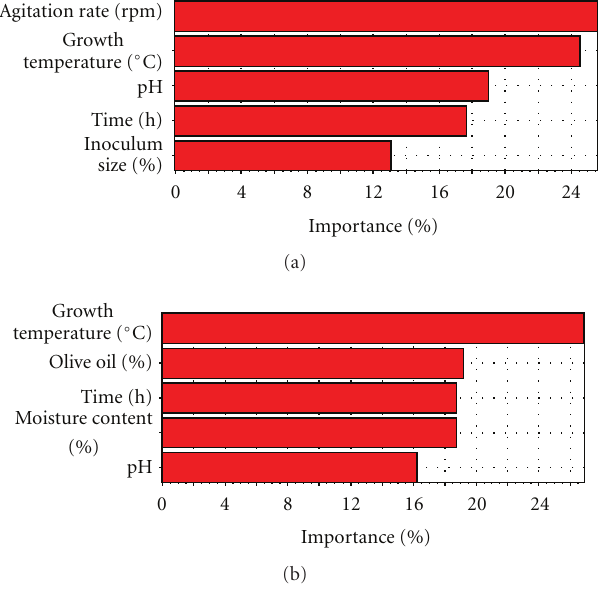
Figure 3: Importance of e ff ective parameters on lipase production in SmF (a) and SSF (b) systems.